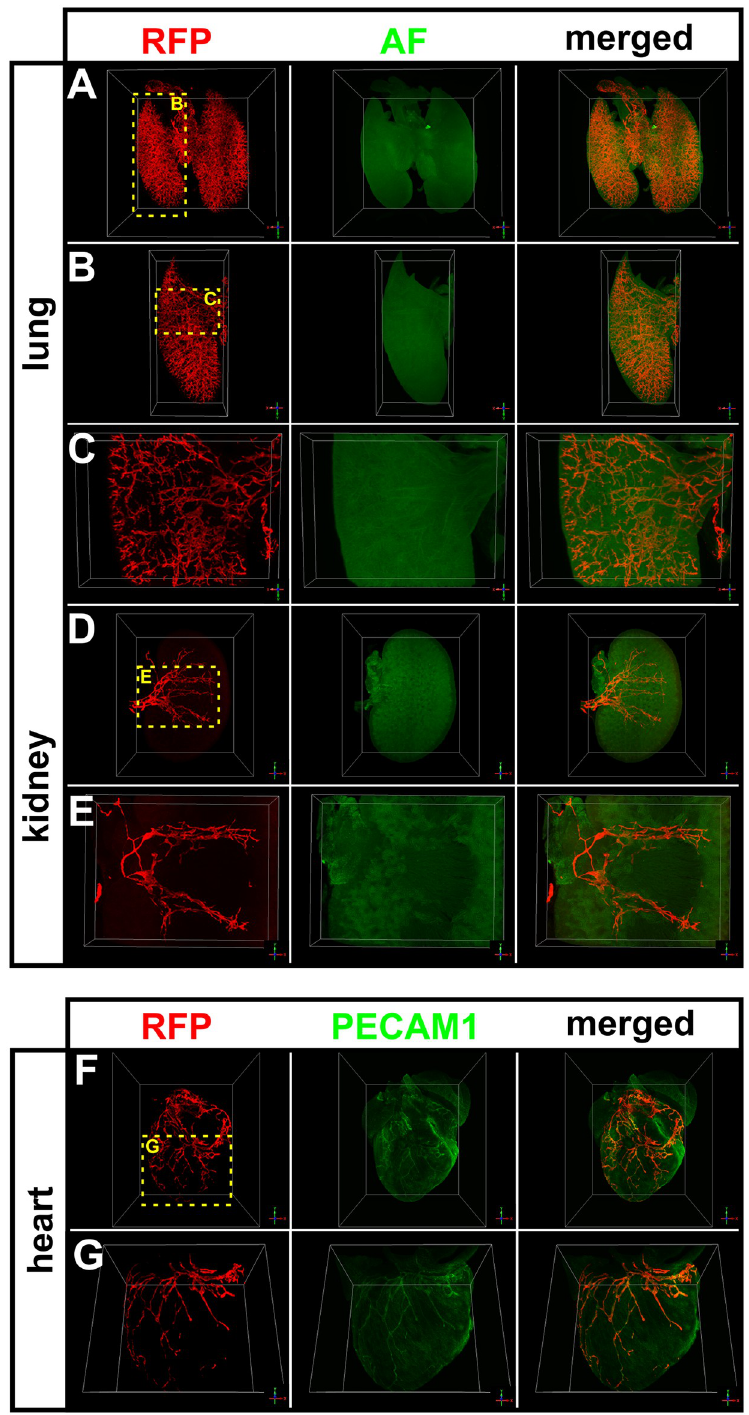
Fig 6. Light sheet microscopic visualization of the lymphatic vasculature in transgenic Vegfr3 -tdTomato reporter mice after organic solvent-based tissue clearing. A-E) Volume reconstruction of lymphatic vessels in the lung (A-C) and kidney (D+E) of Vegfr3 -tdTomato reporter mice at P5. Immunostaining for RFP identified expression of the Vegfr3 -tdTomato transgene. Endogenous tissue autofluorescence (AF) allowed contrasting of the overall organ volume. F+G) 3D visualization of cardiac lymphatic vessels by immunostaining for RFP indicating expression of the Vegfr3 -tdTomato transgene. Blood vasculature was visualized by Alexa Fluor ™ 647-labelled anti PECAM1 antibodies. The yellow boxed areas are magnified in the indicated panels.